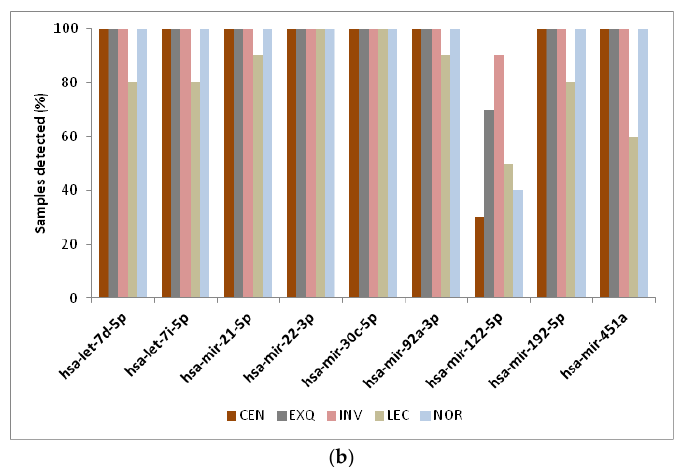
Figure 4. Percentage of detection for each miRNA, employing ( a ) Taqman qPCR or ( b ) Multiplex Circulating miRNA Assay (Abcam).